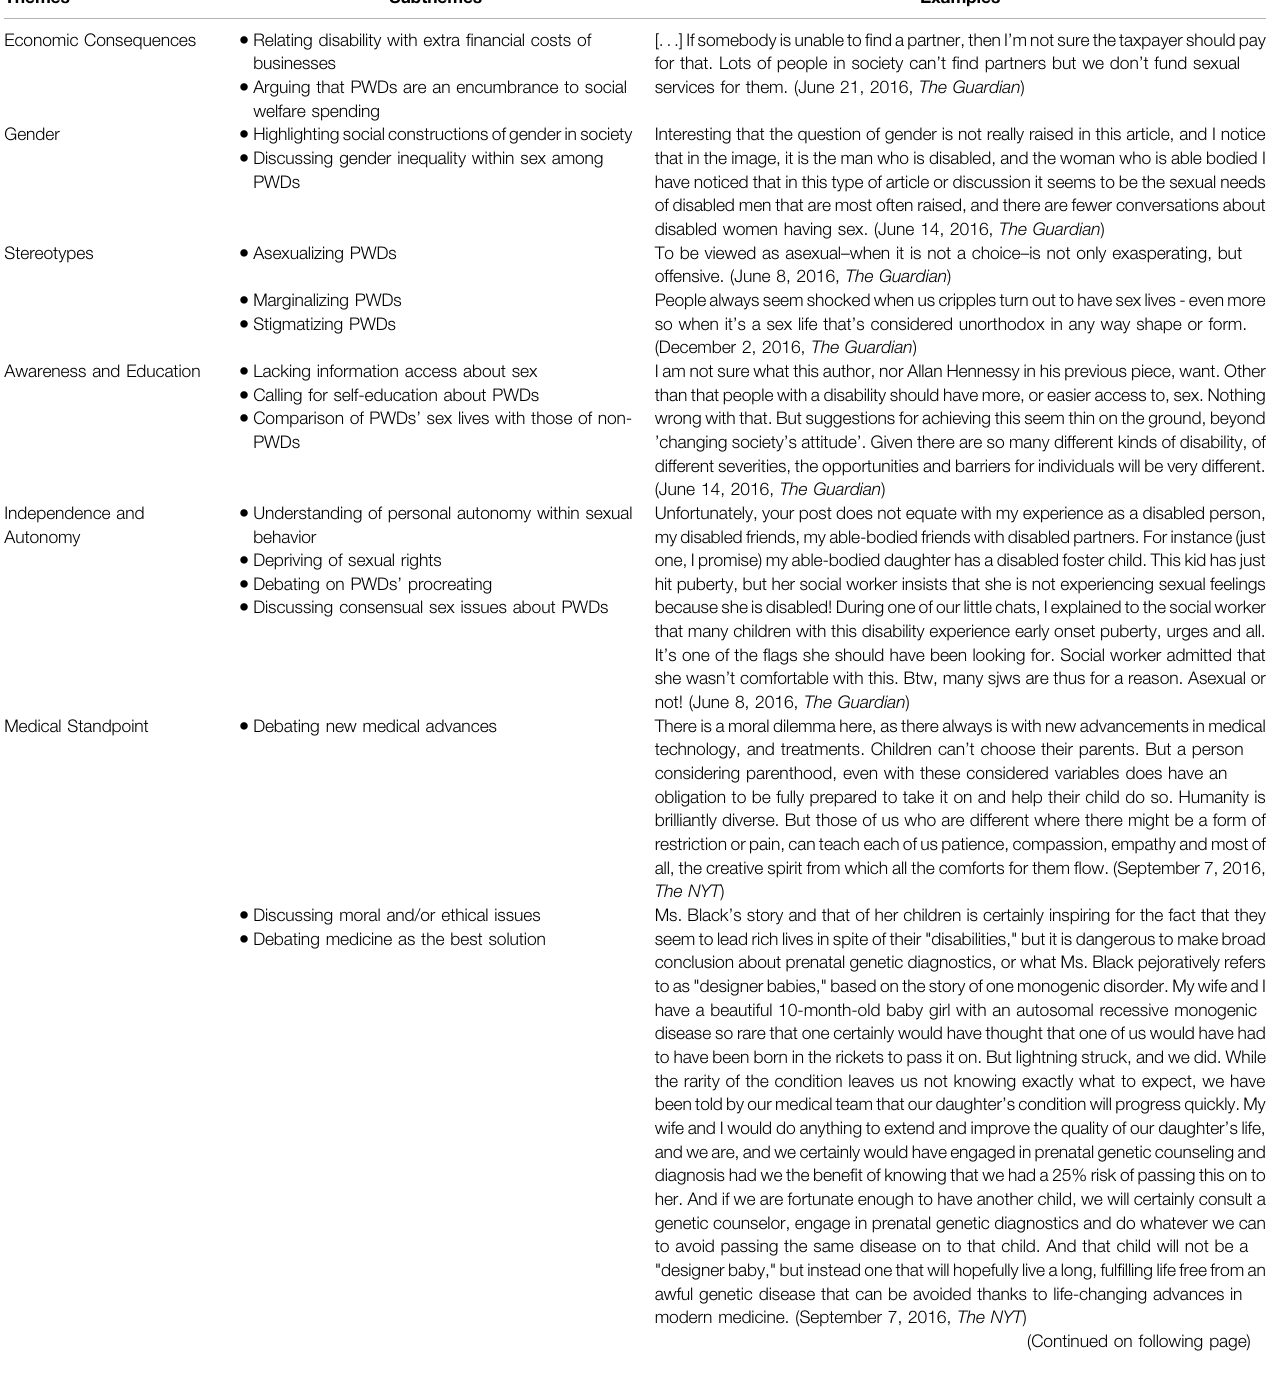
TABLE 3 | Overview of themes, sub themes, and